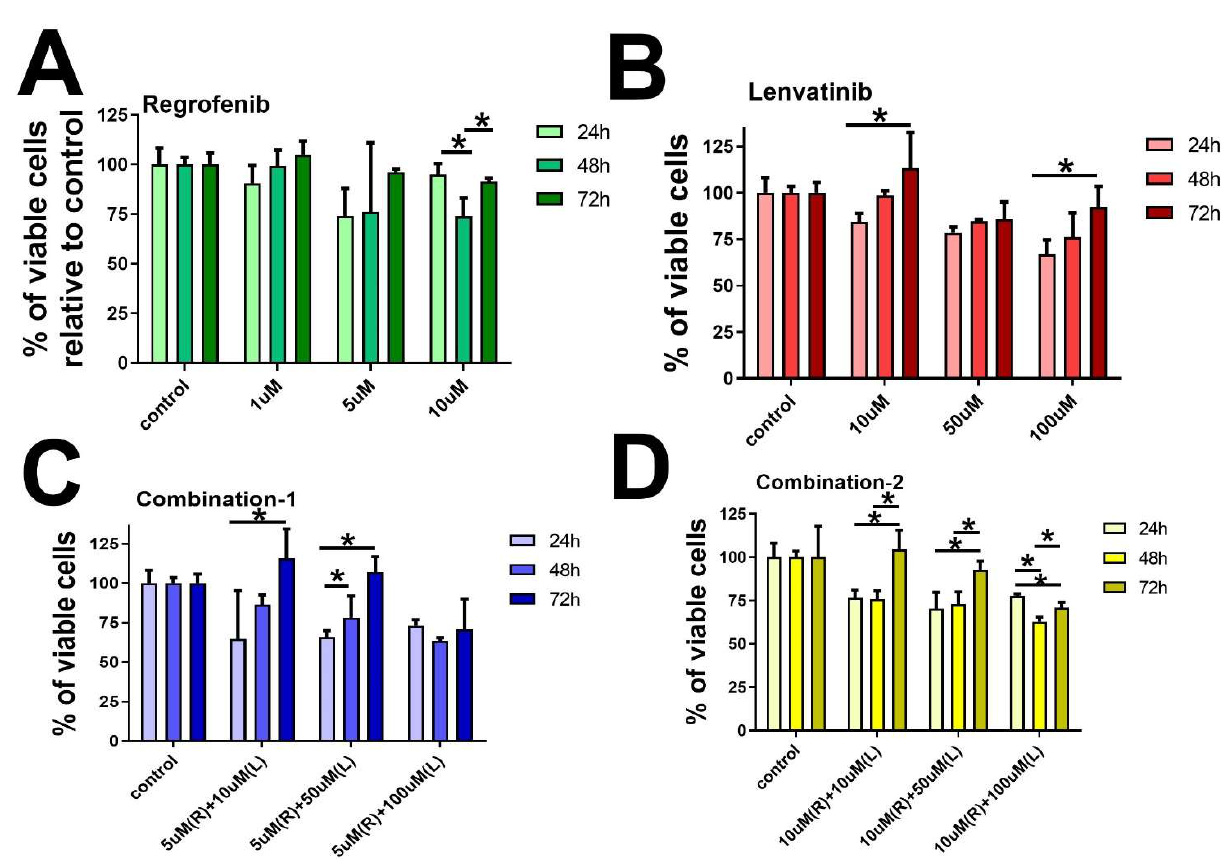
Figure 2. Effect of ( A ) Regorafenib (1, 5, and 10 µM), ( B ) Lenvatinib (10, 50, and 100µM), ( C ) Regorafenib–Lenvatinib (Combination-1) = 51 µM Regorafenib + (10, 50, or 100) µM Lenvatinib, and ( D ) Regorafenib–Lenvatinib (Combination-2) = 10 µM Regorafenib + (10, 50, or 100) 10 µM Lenvatinibon MD-MB-231 cell survival. MD-MBA-231 cells were treated with various concentrations of Regorafenib, Lenvatinib, and a combination of both drugs. Dose and time-dependent survival of the cells were measured over a 24 to 72 hour period using the MTT assay. * statistically significant from the control cells, p -value < 0.05.